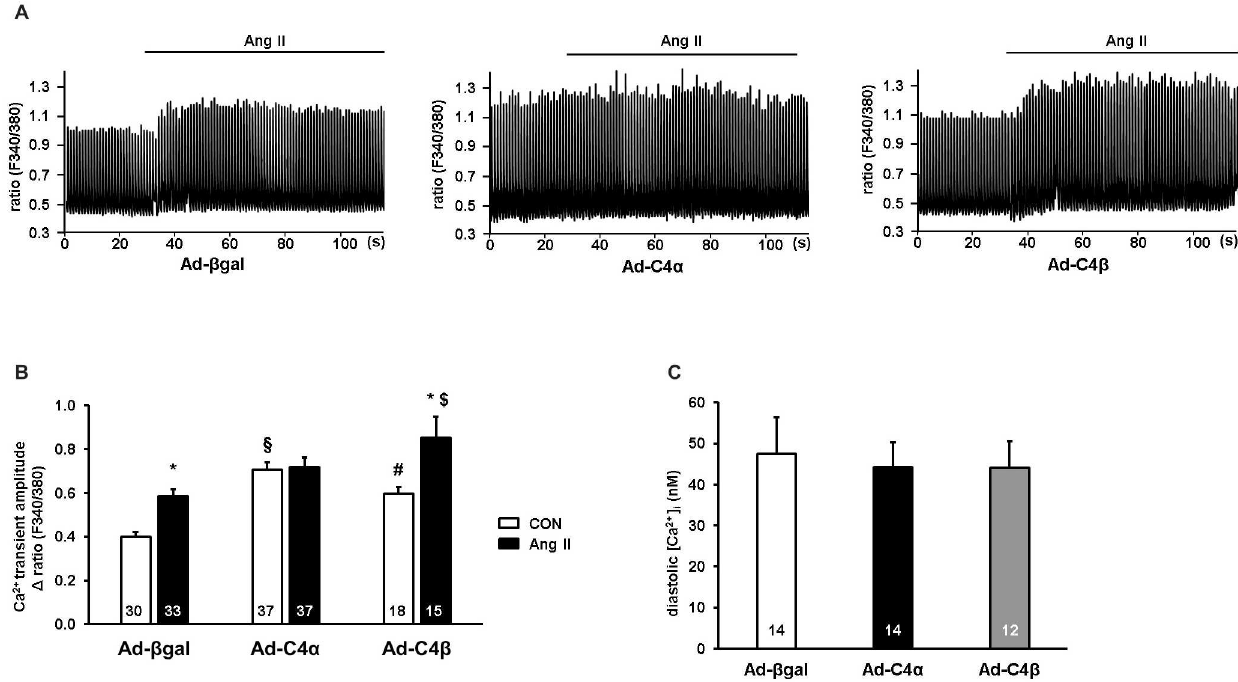
Fig 4. Overexpression of TRPC4 α increasesthe Ca 2+ transient amplitude at baseline and TRPC4 β elevatesthe Ca 2+ transient amplitude at baseline and during Ang II stimulation. A, Ca 2+ transients were measuredin Ad- β gal,Ad-C4 α or Ad-C4 β neonatalrat cardiomyocytes (NRCs) in a normalTyrode solutionwith angiotensin II (Ang II; 1 μ M) or without Ang II during1 Hz of pacing. B, The Ca 2+ amplitudeunder steady state pacingwas significantly increasedin Ad-C4 α and Ad-C4 β cardiomyocytes. Ang II stimulationresulted in an elevationof the Ca 2+ peak in Ad- β galand Ad-C4 β but not Ad-C4 α cardiomyocytes as analyzedafter 30–60 s of Ang II application. * P < 0.05vs Ad- β galCON and Ad-C4 β CON; # P < 0.05vs Ad- β galCON; § P < 0.05vs Ad- β galand Ad-C4 β CON; $ P < 0.05vs Ad- β galAng II/PE. C, Diastolic [Ca 2+ ] i levels measured with Fura-2 were not different betweenAd- β gal,Ad-C4 α or Ad-C4 β NRCs. Cells from at least three different experiments were analyzed.N-number of cells is indicatedin the bars.